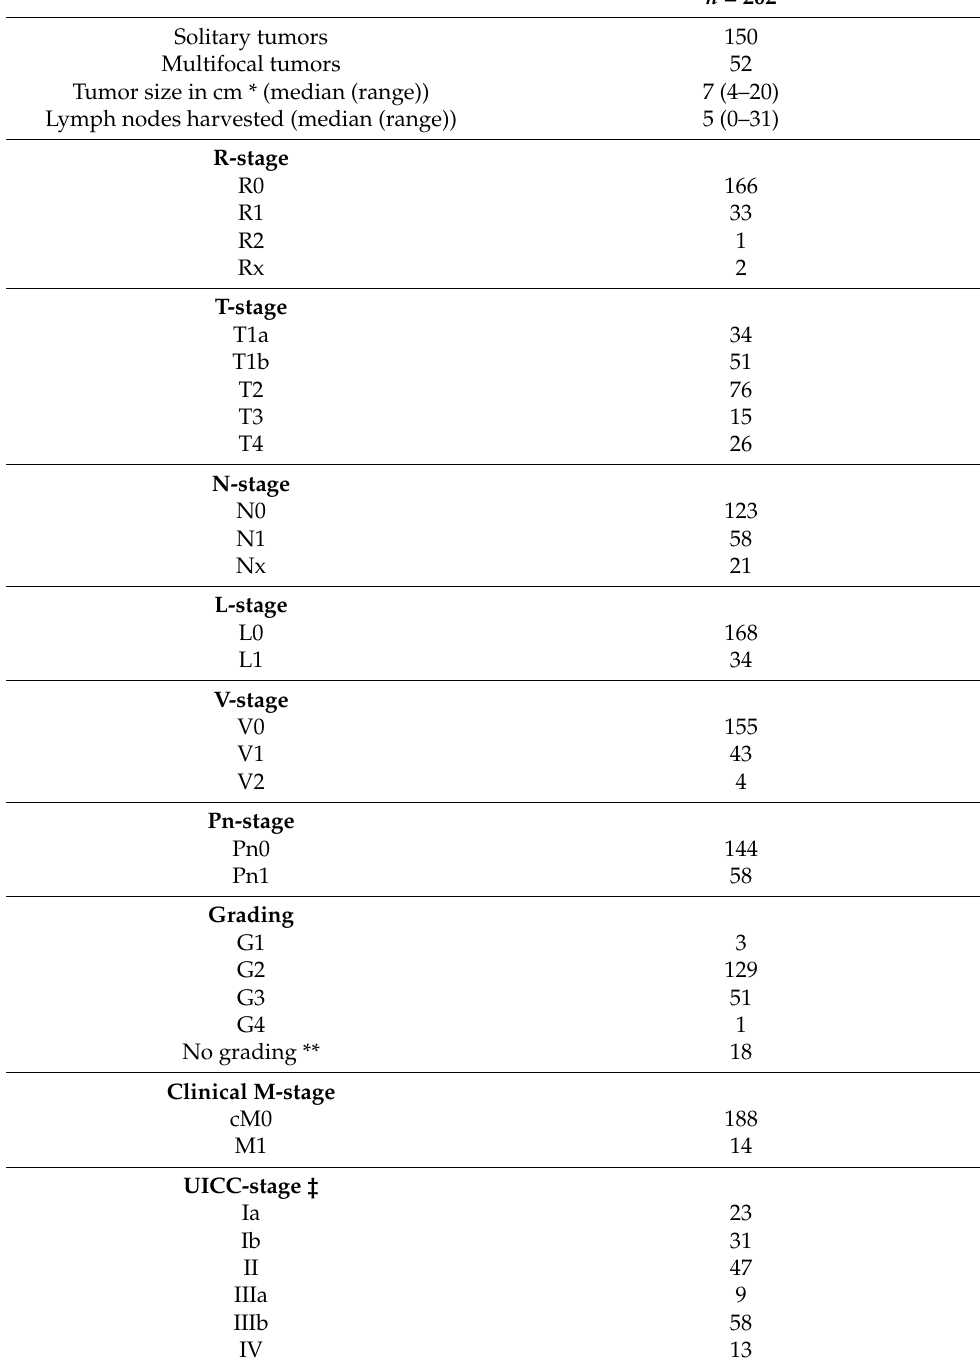
Table 5. Histopathological staging after primary liver resection. n = 202 Solitary tumors 150 Multifocal tumors 52 Tumor size in cm * (median (range)) 7 (4–20) Lymph nodes harvested (median (range)) 5